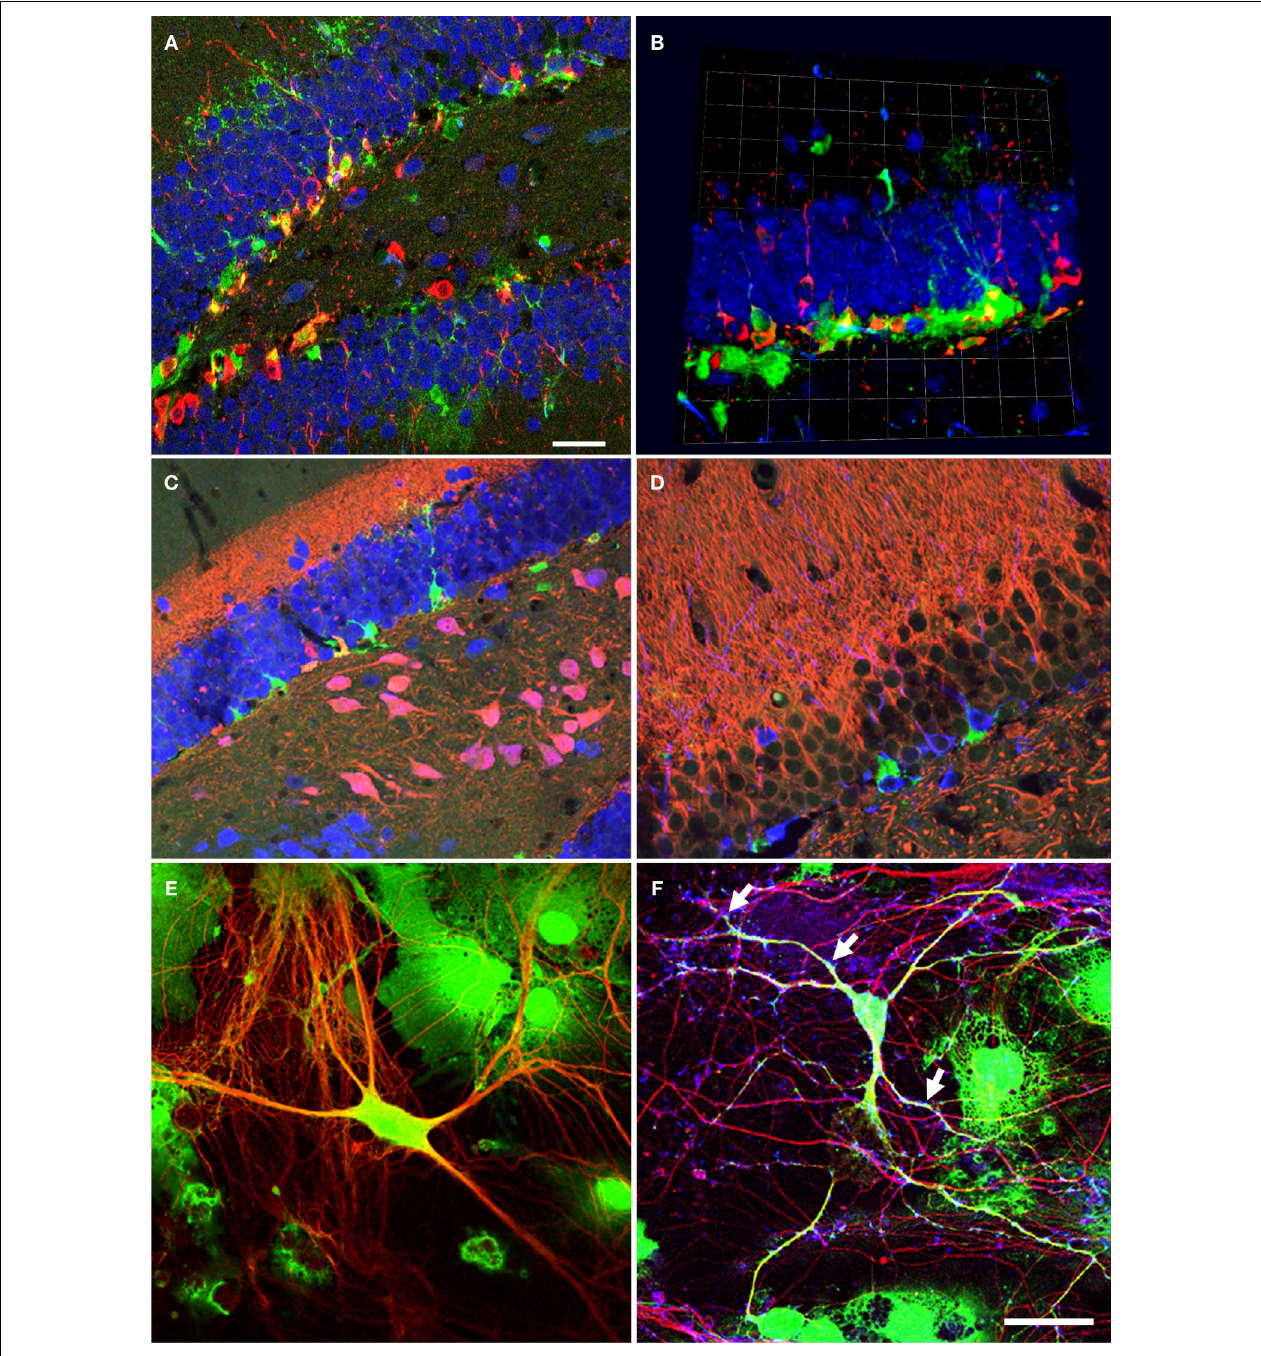
FIGURE 1 | Neural precursor cells in their local microenvironment in vivo and in vitro . (A) Immunohistochemical analysis of a hippocampal section from mouse showing the close association of neural precursor cells with neurons. Confocal image (optical section of 1 µm thickness). Green: Nestin-GFP; Red: Dcx, Blue: NeuN; Scale bar, 25 µm. (B) Confocal projections (56 × ) of the dentate gyrus (z-stack of 11 optical sections with 2 µm thickness); Green: Nestin-GFP; Red: Dcx; Blue: NeuN; one square in the underlying grid equals 16.4 µm. (C) Calretinin- immunohistochemistry highlights the inner molecular layer. Radial glia-like type-1 cells (Green) reach into this area, which receives the input from the entorhinal cortex. Green: NestinEGFP; Red: Calretinin; Blue: NeuN. (D) Newborn neurons in